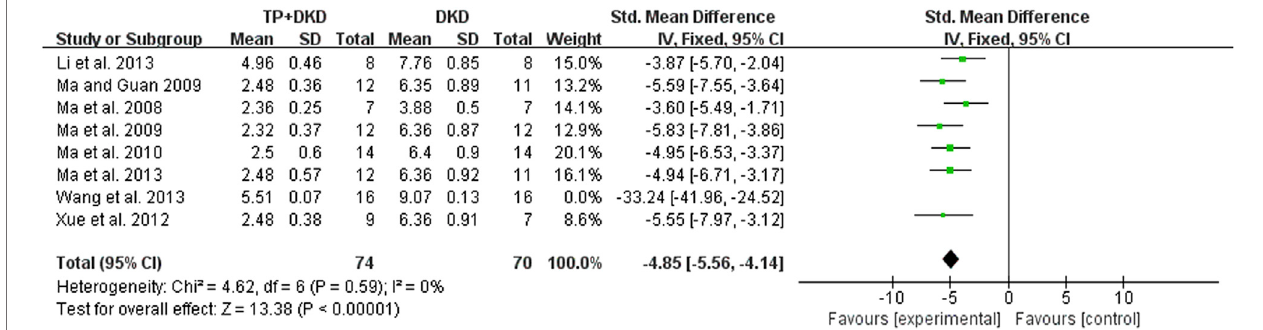
FIGURE 5 | Forest plot of UACR outcome (not included by Wang et al., 2013).